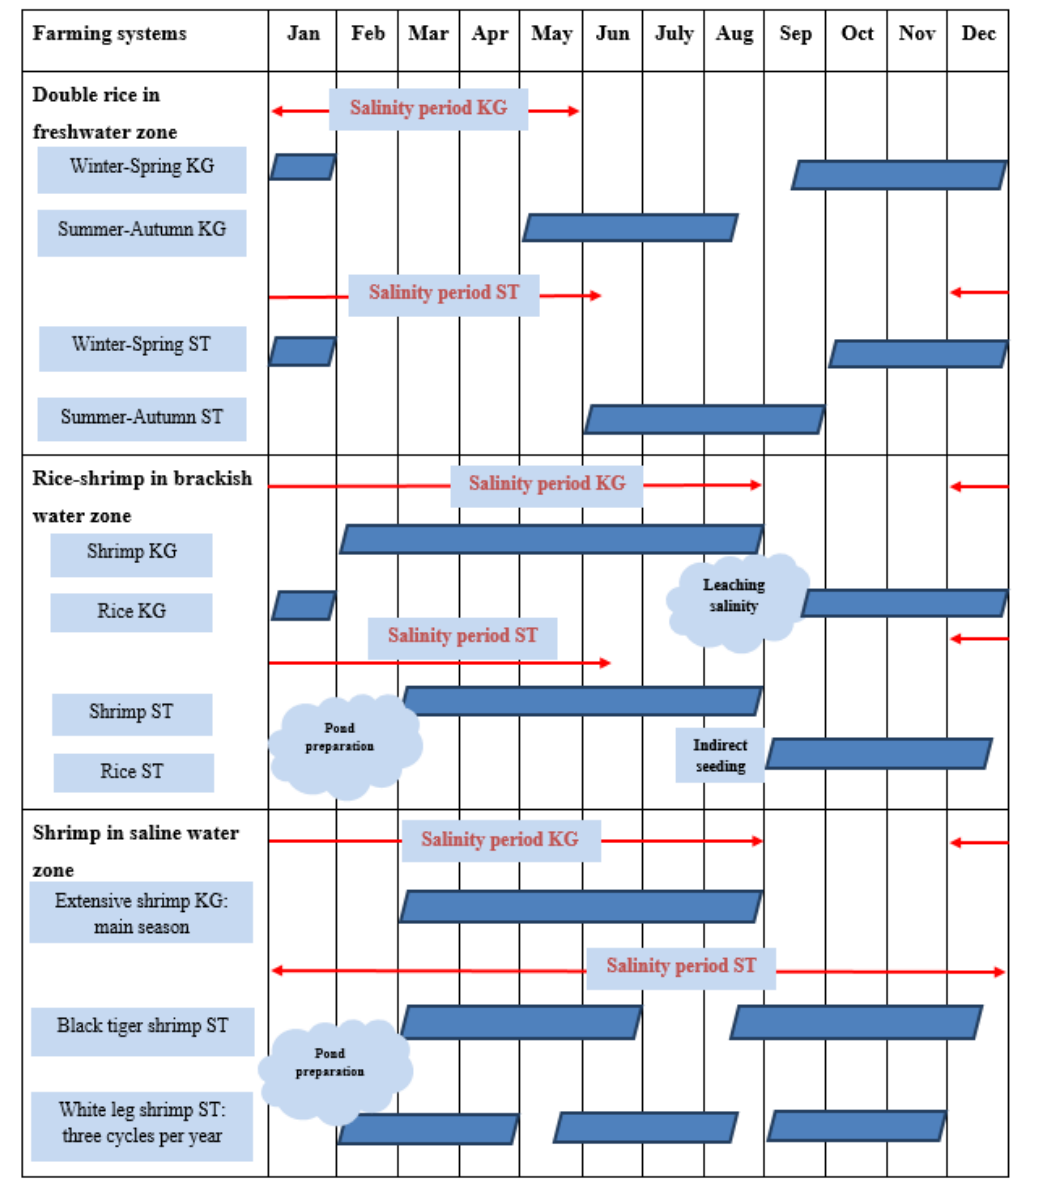
Fig. 2 . Cropping calendars in Kien Giang (KG) and Soc Trang